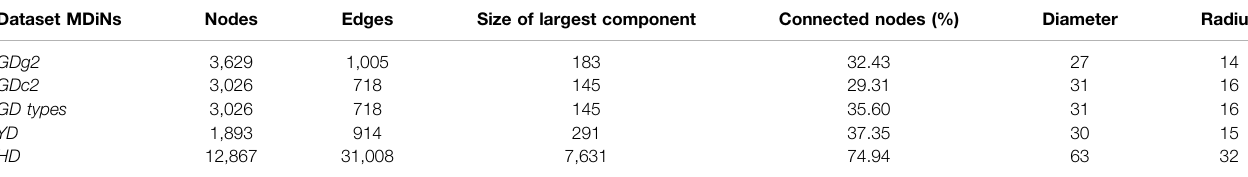
TABLE 3 | General characteristics of the mass-difference networks built from the different datasets. Dataset